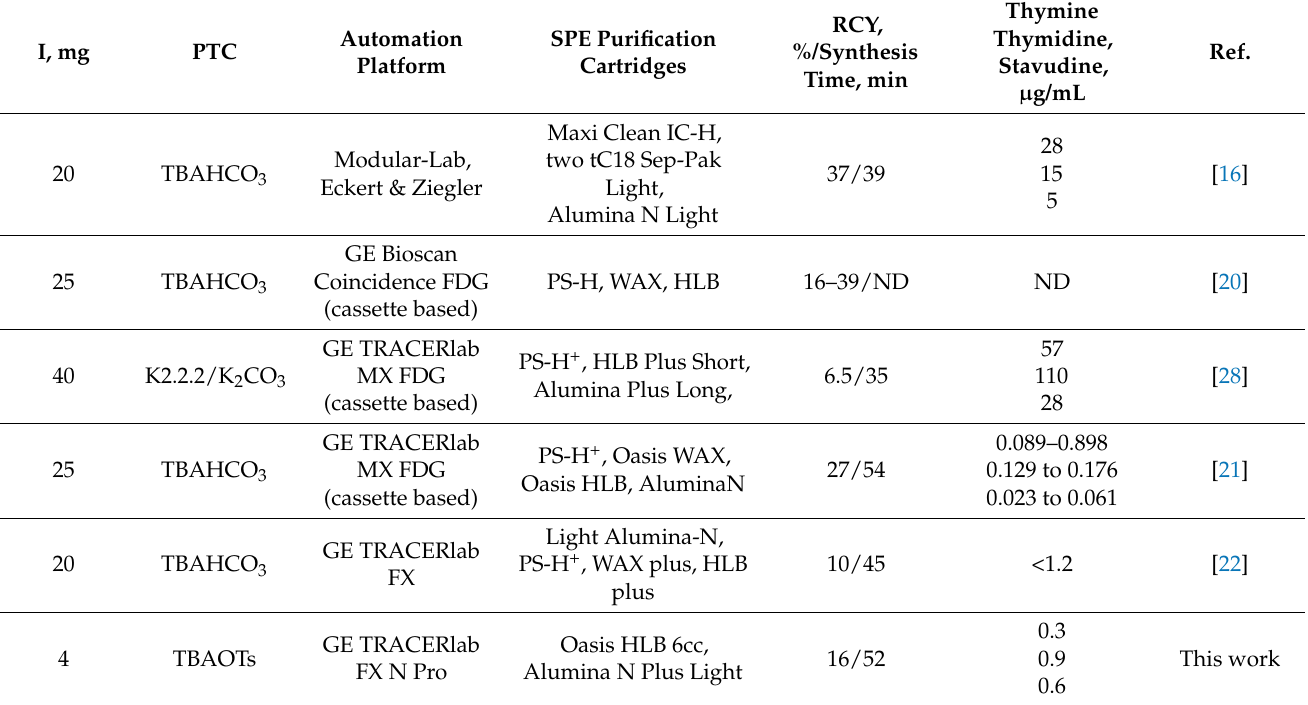
Table 1. Synthesis of [ 18 F]FLT via radiofluorination of I on various automation platforms and SPE based purification; RCY—radiochemical yield, decay